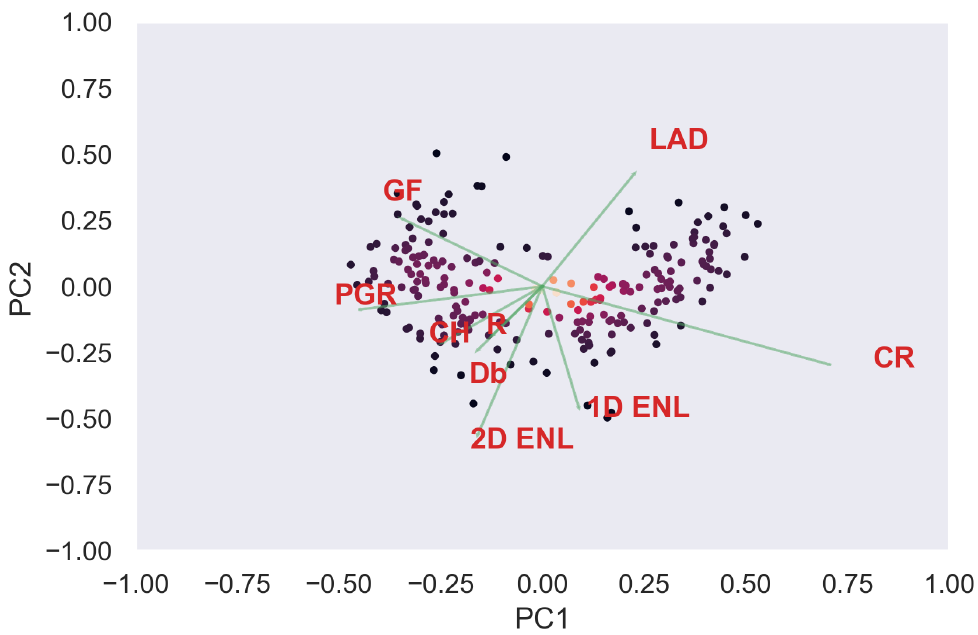
Figure A52. ULS PCA band 1 and 2 loadings at 5m grid size.